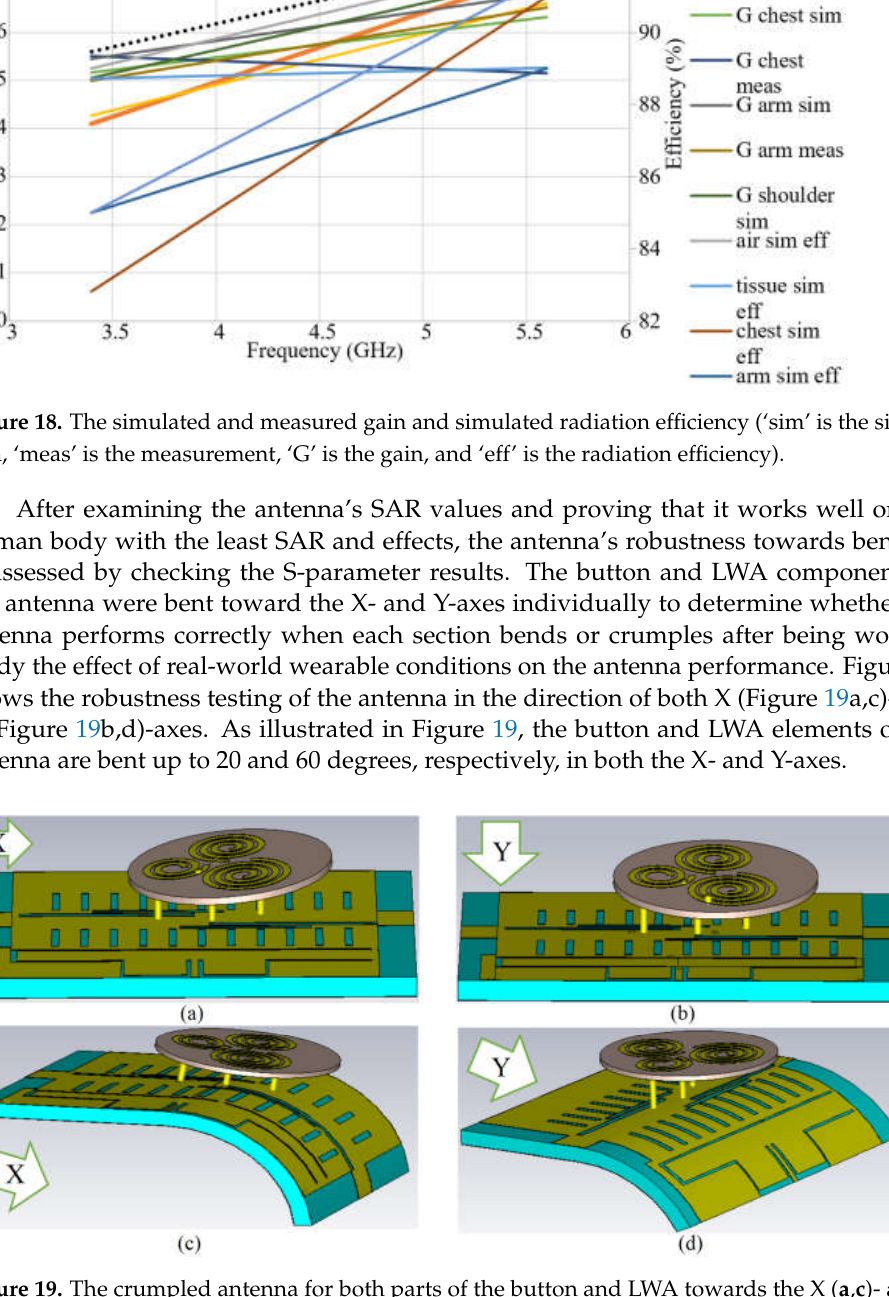
Figure 20. The robustness investigation of the proposed antenna in terms of S-parameters (( a ) trans- mission coefficient results, ( b ) reflection coefficient results).